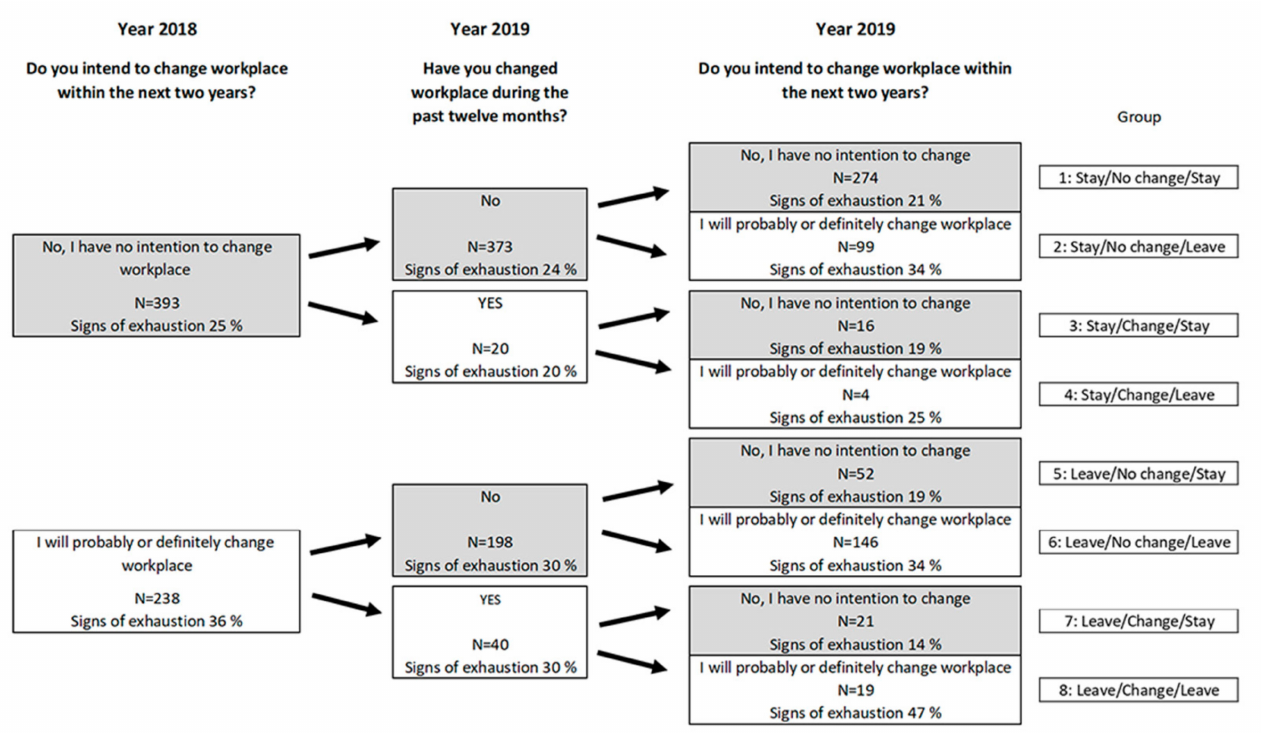
Figure 1. Longitudinal patterns of intended and actual change of workplace and its association with signs of exhaustion among 631 principals in compulsory